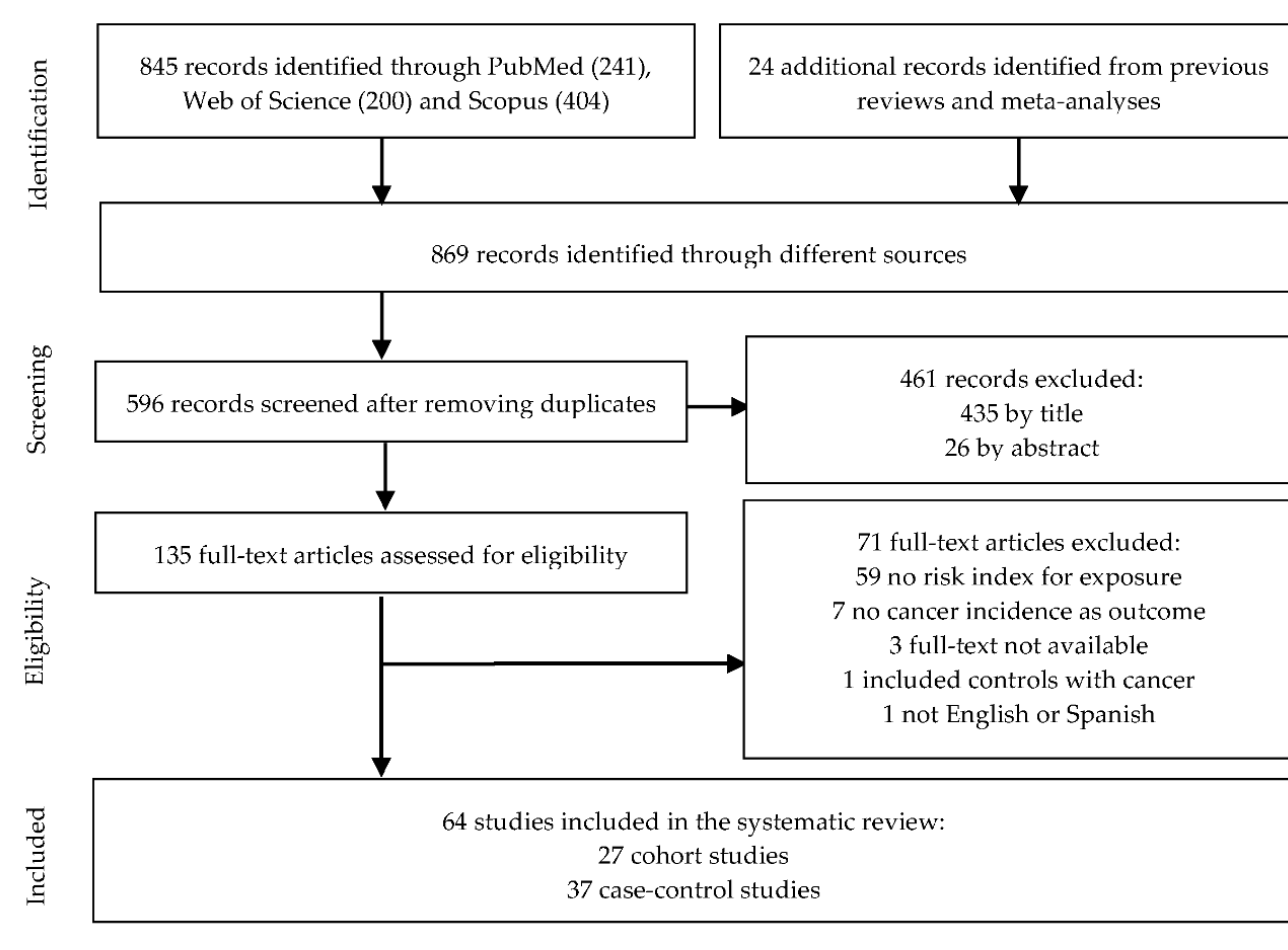
Figure 1. Prisma diagram.